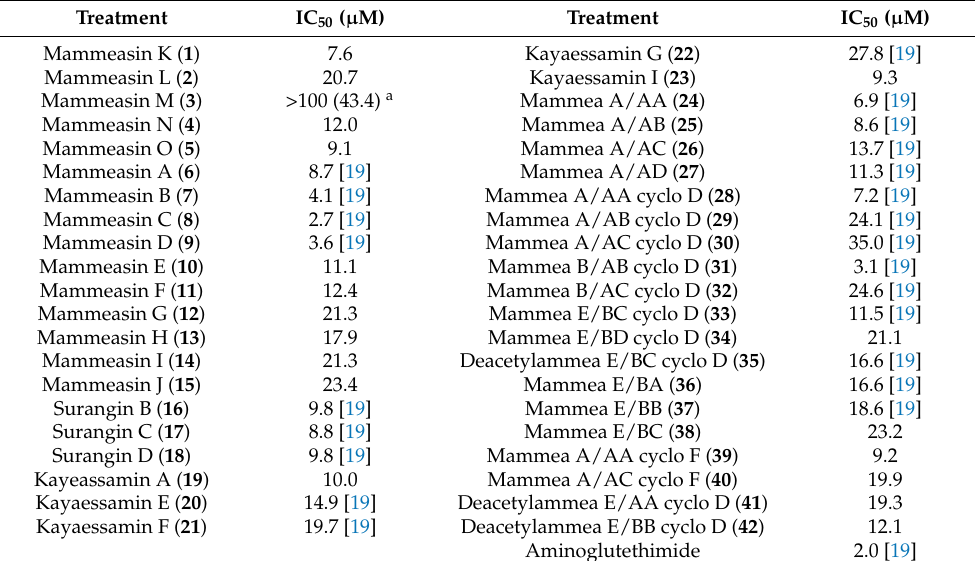
Table 5. IC 50 values of coumarin constituents ( 1 – 11 , 16 , 17 , 23 – 25 , 28 , 31 , 34 , 38 , and 39 ) from the flowers of M. siamensis against human recombinant aromatase.